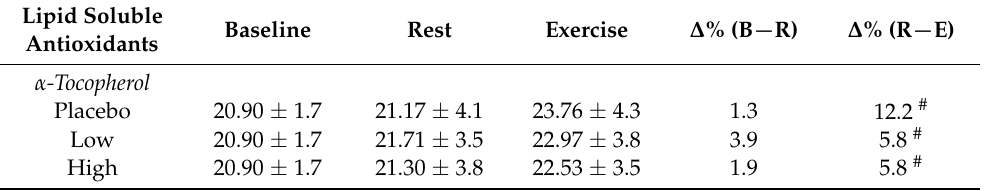
Table 2. Lipid soluble antioxidants at rest (pre-exercise) and following exhaustive exercise for placebo, low-dose and high-dose supplemented groups. All values are expressed as means ± standard deviation and expressed as mmol · L − 1 . B = Baseline; R = Rest; E = Exercise. * denotes significant interaction effects of group and time ( p < 0.05). # denotes significant main effects of time at the pre vs. post exercise time